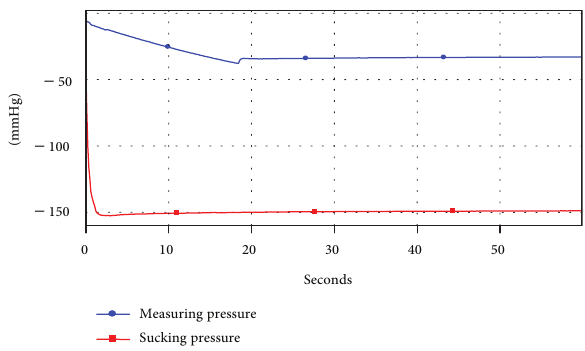
Figure 5: Performance of new bottle design with a vented